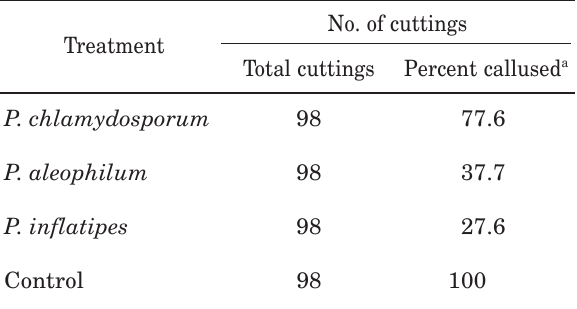
Table 2. Inhibition of callus formation in cv. Chardon- nay cuttings by Phaeoacremonium chlamydosporum, P. aleophilum, and P. inflatipes . Cuttings were exposed to infested sand for 3 weeks.